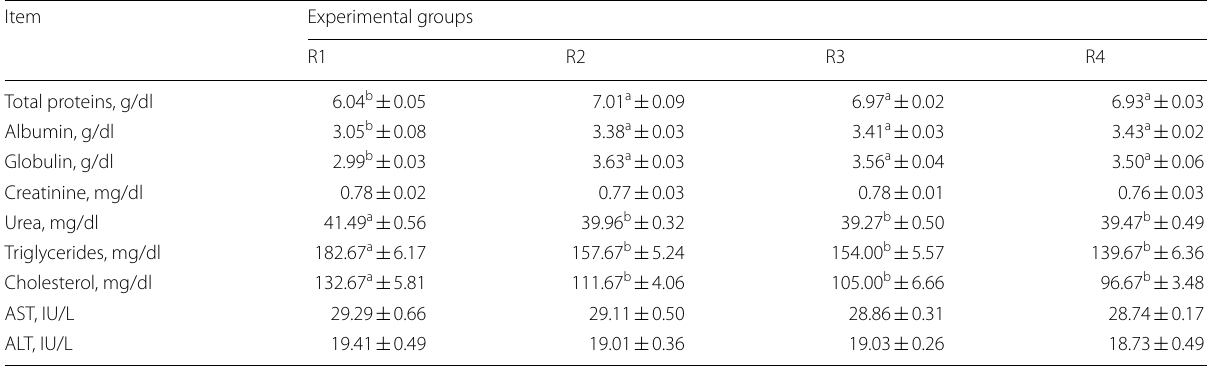
SE) of NZW rabbits ±